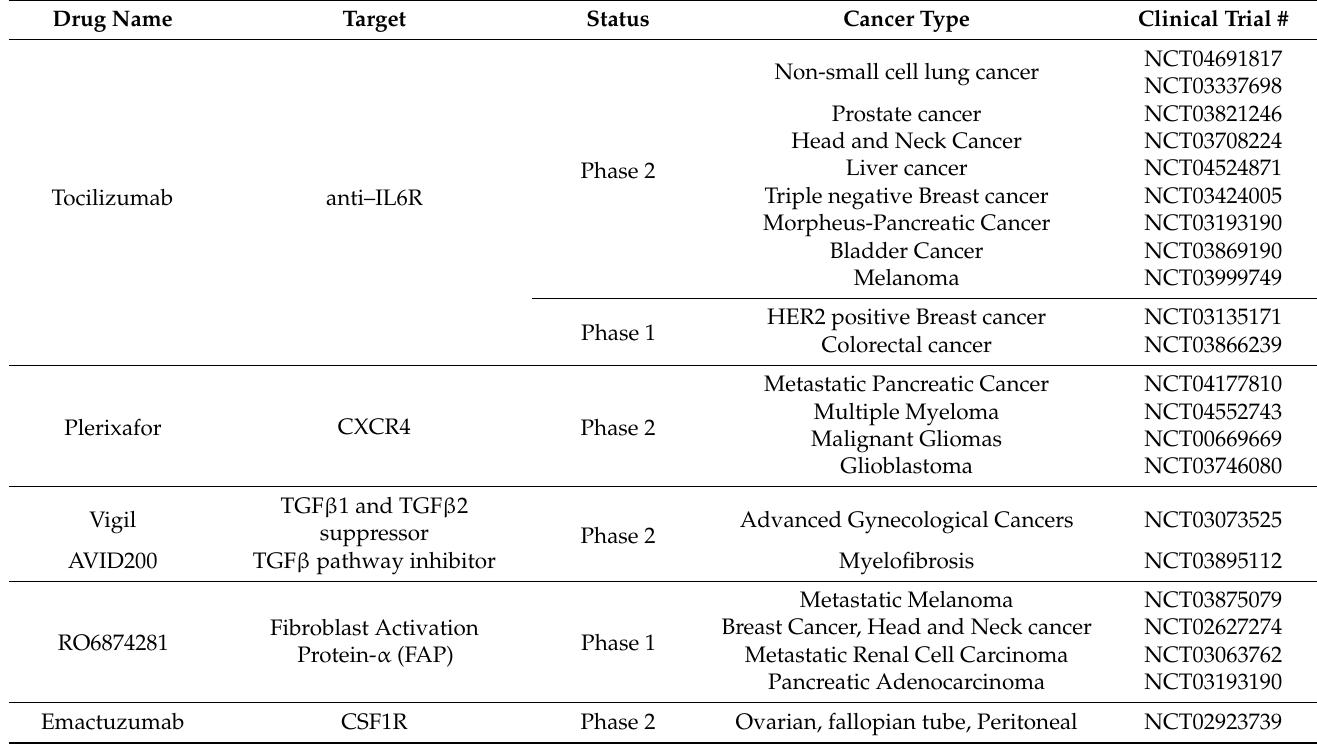
Table 2. Therapeutic agents targeting few tumor microenvironment components/pathways in interventional phase 1 and 2 clinical trials currently active and recruiting or not yet recruiting. Data acquired from the U.S. National library of